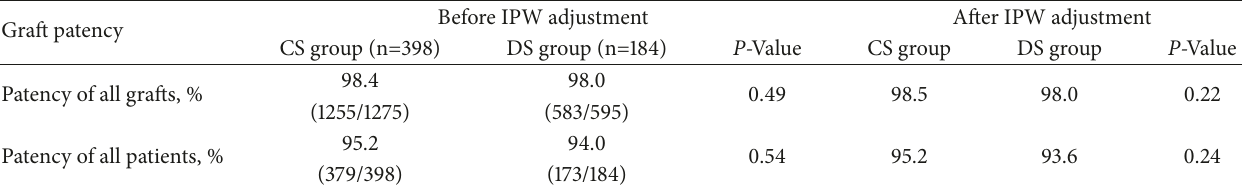
Table 4: Primary outcome: effect on early graft